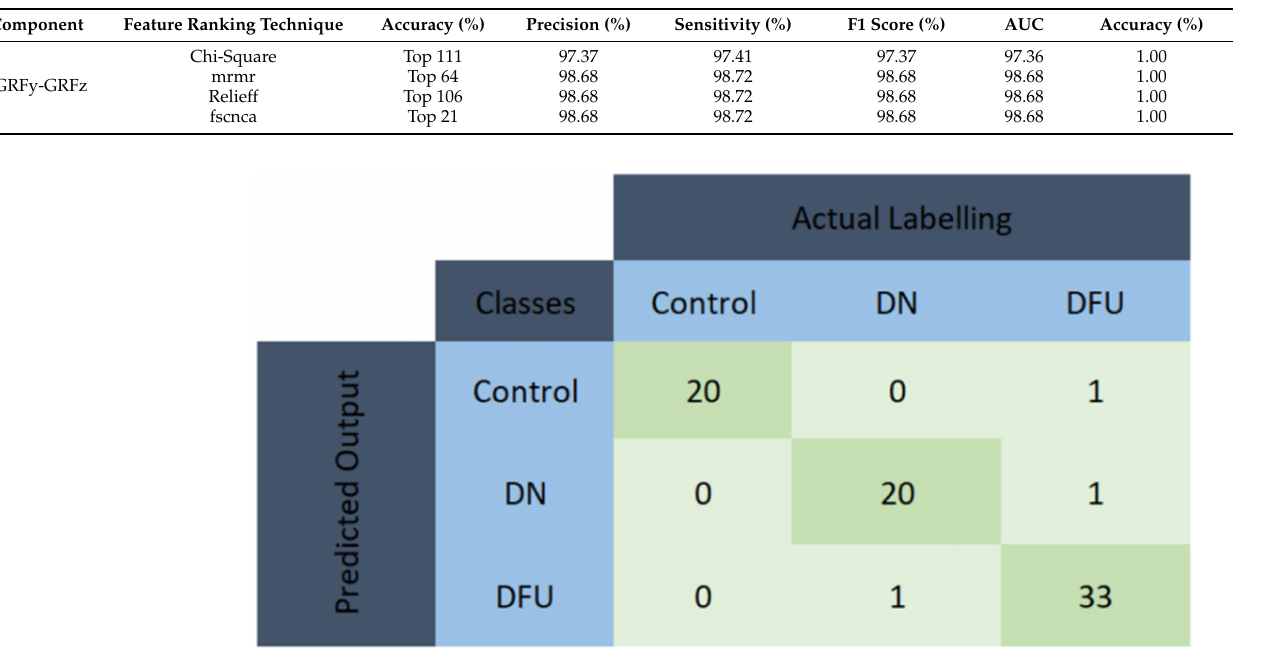
Figure 8. Confusion matrix for KNN model using the top 12 features extracted from GRFx and GRFz signals and feature ranked using the fscnca feature ranking